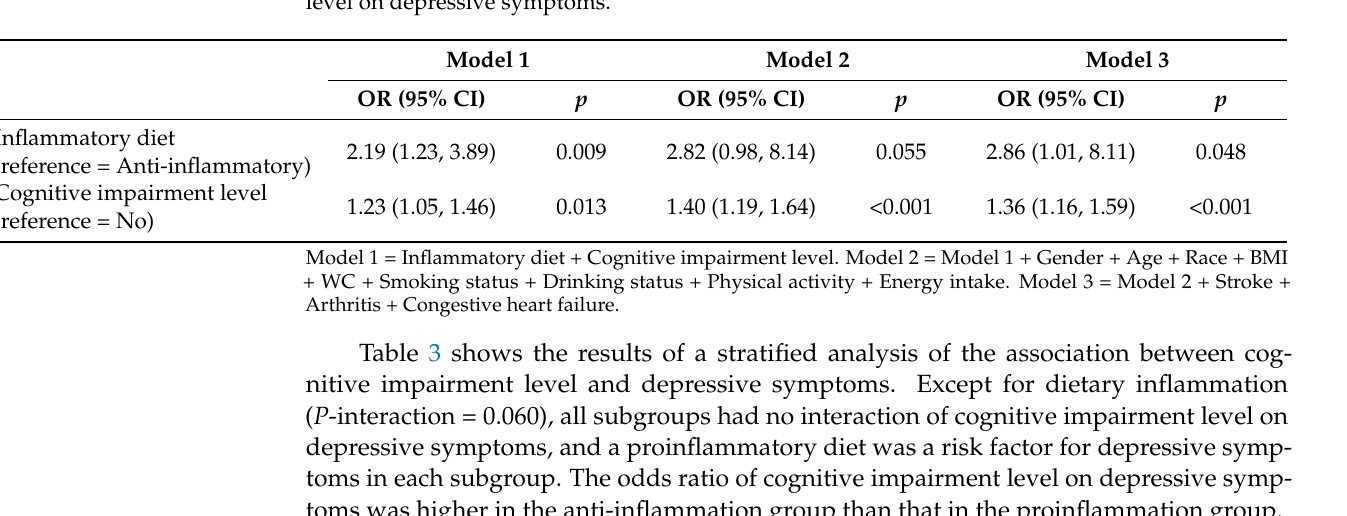
Table 2. Logistic regression model for the association of Inflammatory diet and Cognitive impairment level on depressive symptoms.